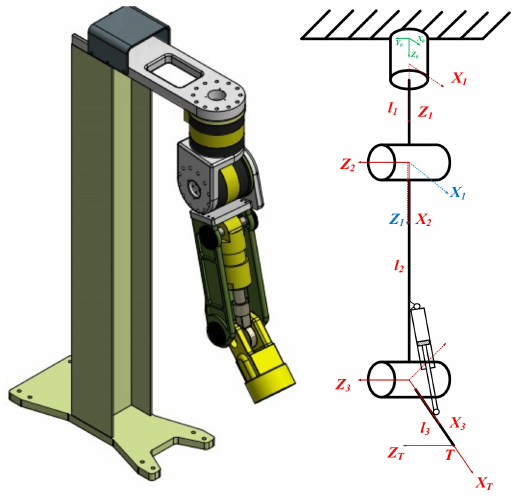
Figure 1. The structure of the 3-DOF